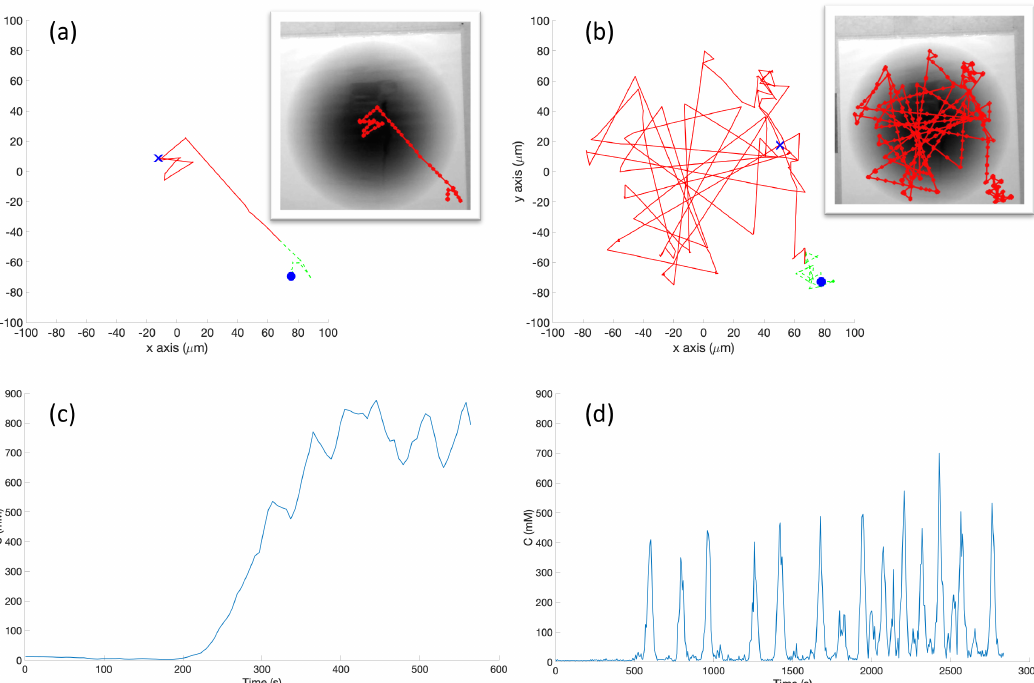
Figure 13. Case 4: Without obstacles, in the homogeneous/no effluent environment, typical trajectories of the e-puck robot running ( a ) the basic chemotaxis controller, and ( b ) the RapidCell chemotaxis controller. In each trajectory, the initial position is shown as a blue circle and the terminal position is shown as a blue “X”. Positions corresponding to concentrations less than 1m M are shown in dashed green, otherwise shown in red.